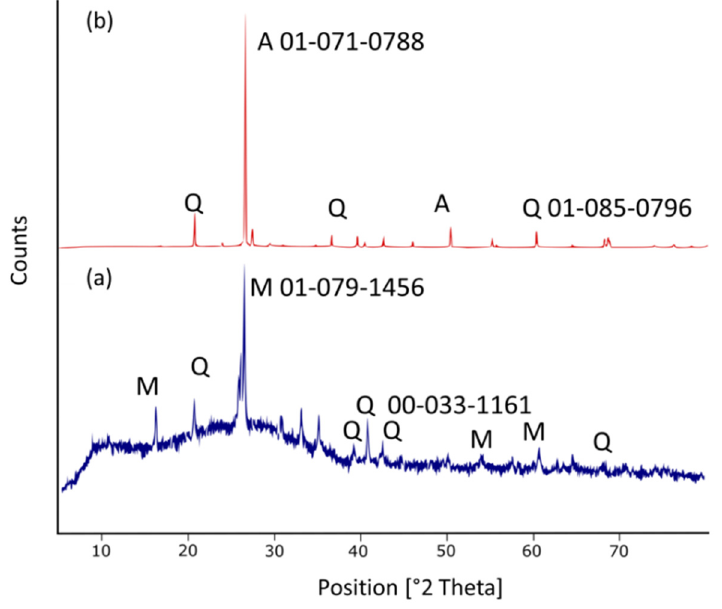
Figure 4. XRD diffractogram of fly ash geopolymer mortar at different curing age: ( a ) 28 days; and ( b ) 10 years.